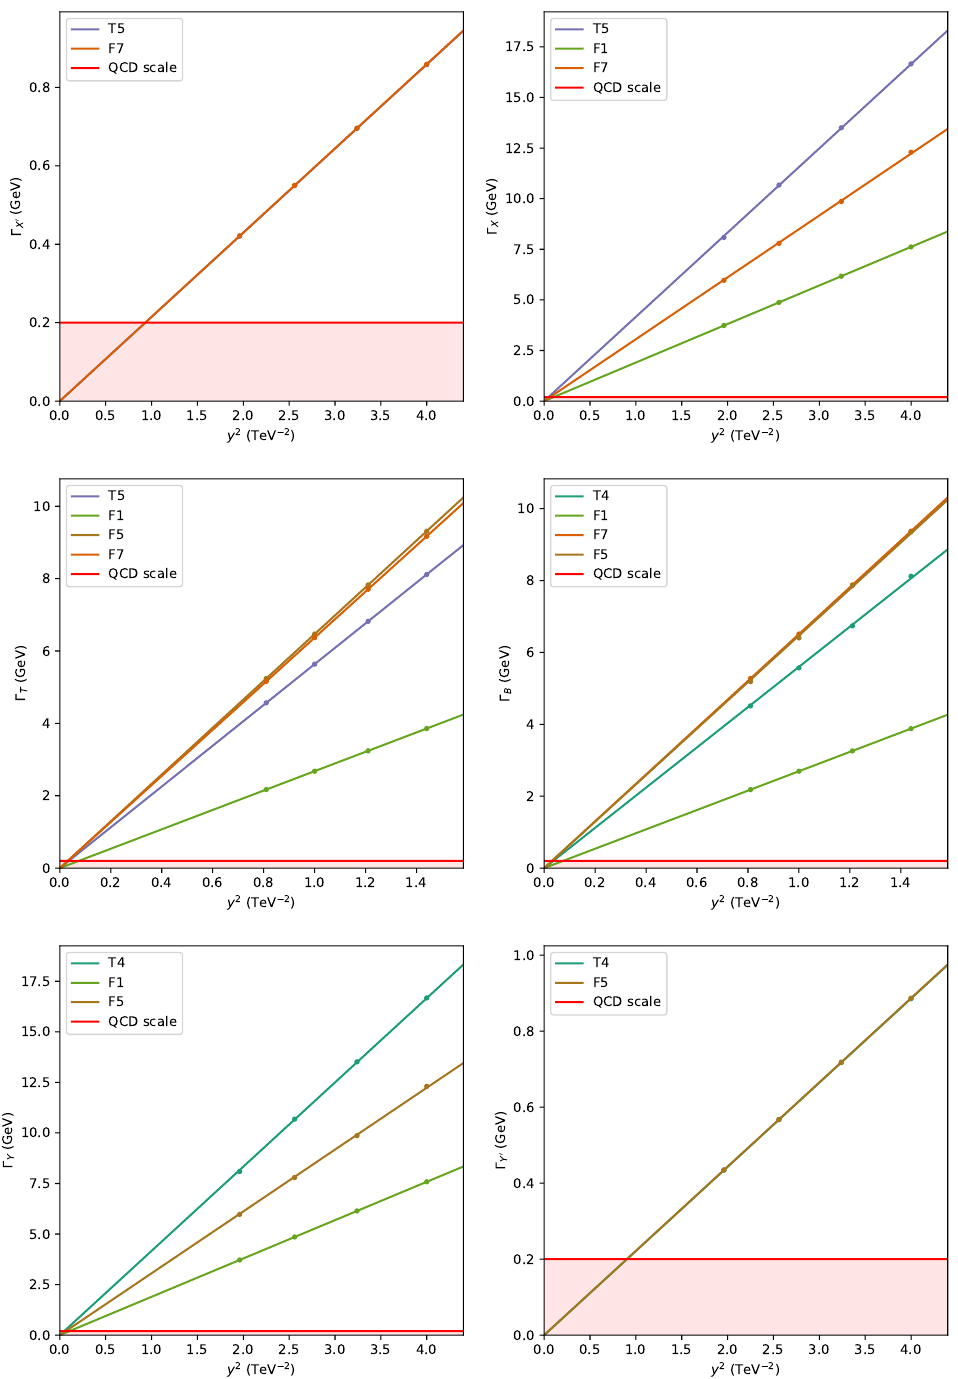
Figure 7 . Total decay width of T (left) and B (right) vs the dimension-5 Yukawa coupling y for each multiplet without dimension-4 couplings and M Q = 2 TeV.